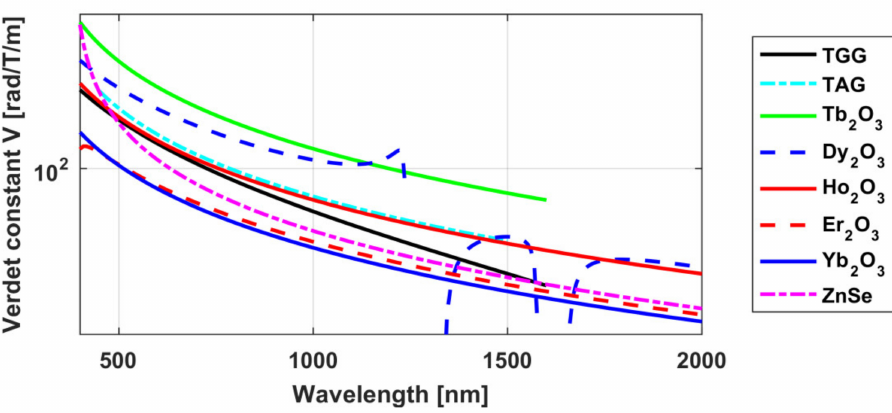
Figure 5. Dispersion trends of the Verdet constant of TGG [39], Tb 2 O 3 [39,40], TAG